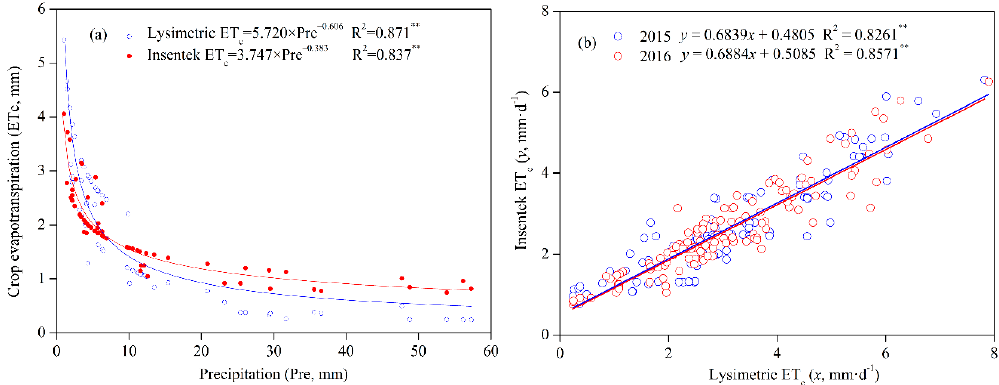
Figure 8. ( a ) Relationships between crop evapotranspiration (ET c , mm) and precipitation (Pre, mm) on rainy days fitted to a negative power function. ( b ) Linear regression between Insentek ET c and lysimetric ET c . Table 4. Test for linear regression and goodness of fit between Insentek ET c ( y ) and lysimetric ET c ( x ) data of summer maize in 2015 and 2016.